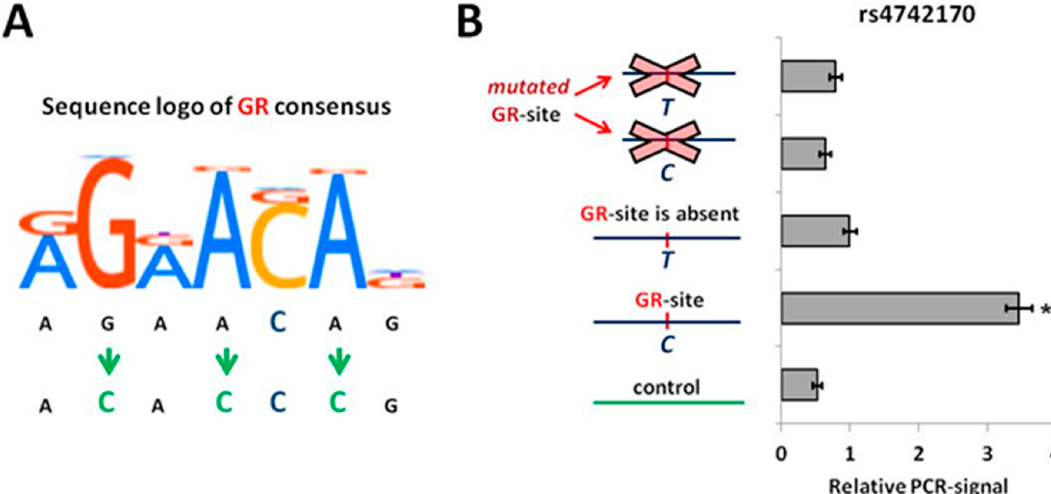
Figure 3. Risk “T” allele of rs4742170 disrupts GR-binding site in IL33 enhancer. ( A ) Position weight matrix of GR-binding site and the scheme of its point mutagenesis. ( B ) The level of GR binding to rs4742170 alleles was estimated by pull-down assay with nuclear extracts from cortisol-stimulated NCIH-196 lung cancer cells. The results of three independent experiments are represented. * p < 0.01.